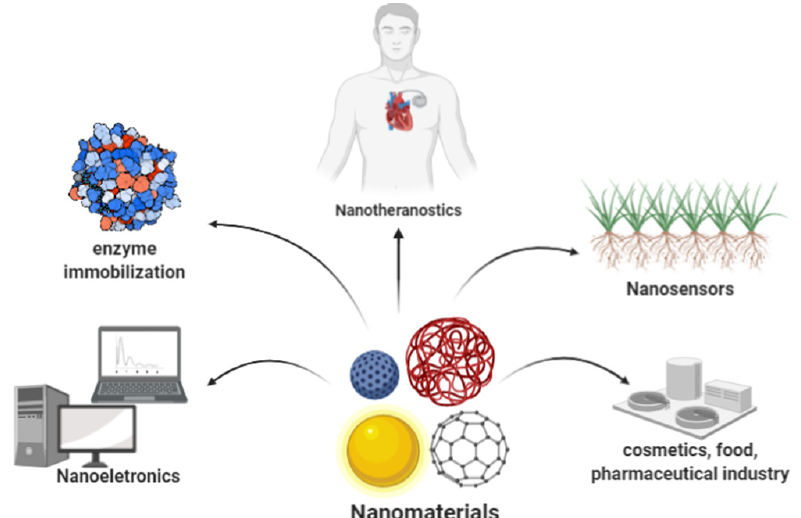
Figure 3. The several applications of nanomaterials.